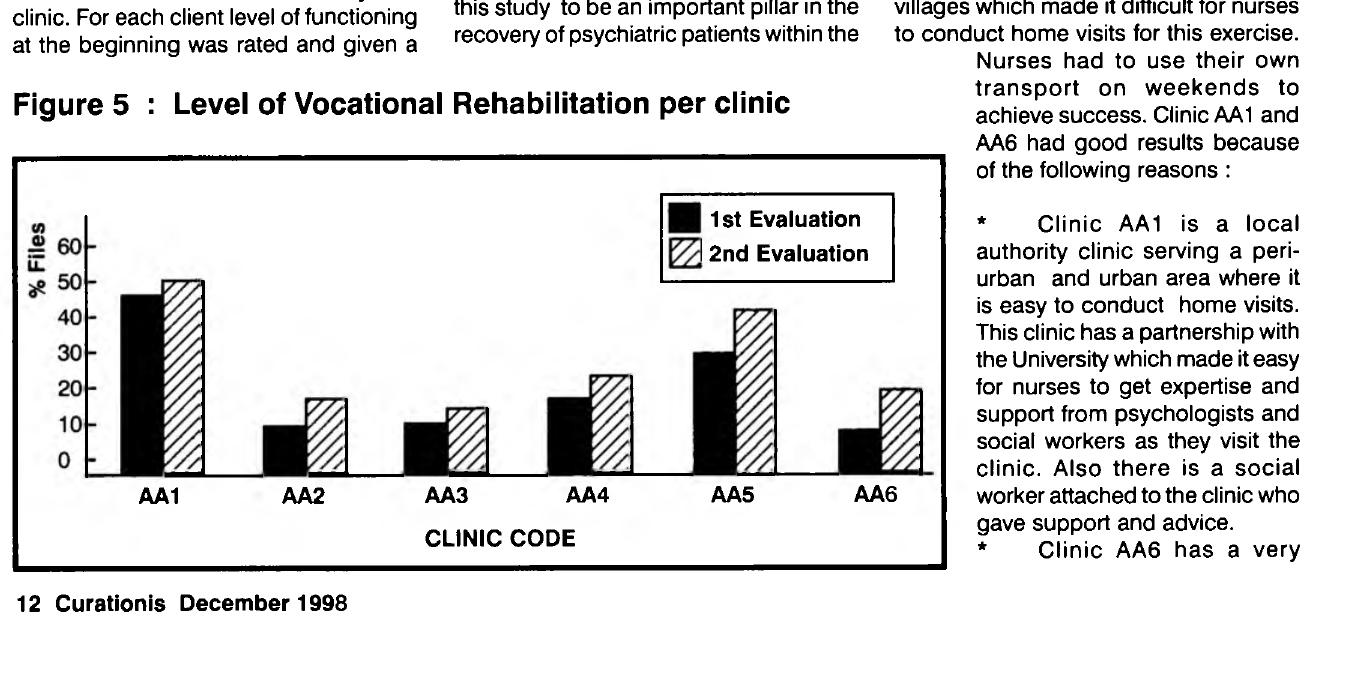
Figure 5 : Level of Vocational Rehabilitation per